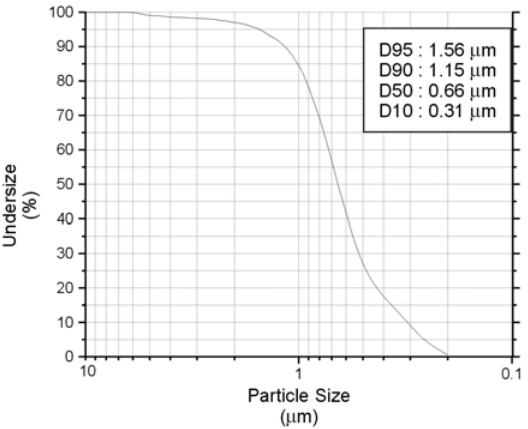
FIGURE 2 Particle size distribution curve for 70%Ag30%Pd on 40wt.% BaTiO 3 .